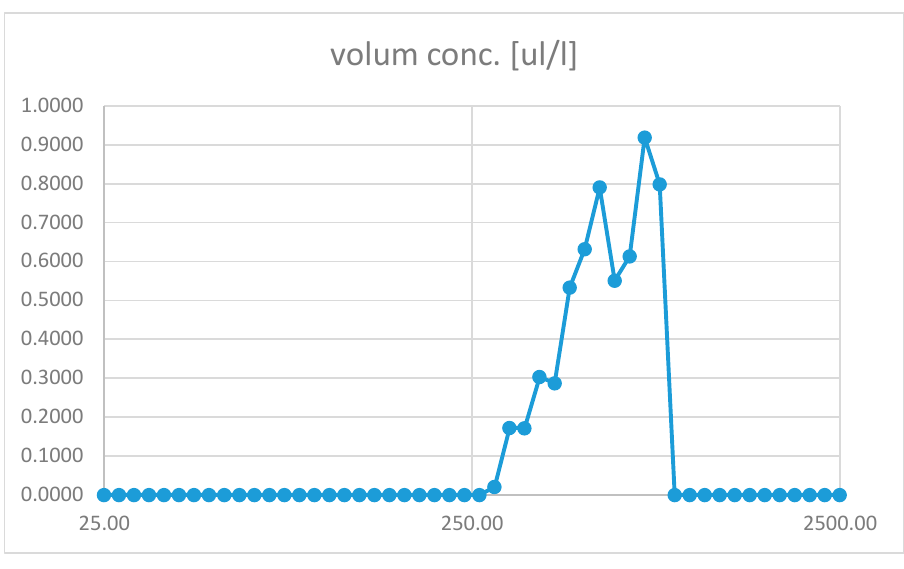
Figure 8. MP size distribution measured in Goro.